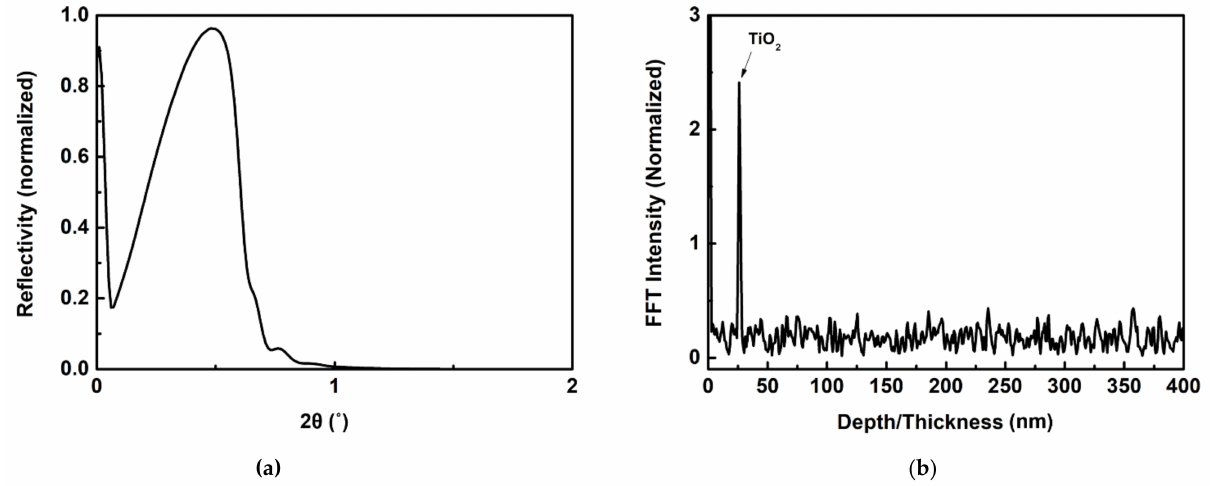
Figure 8. ( a ) X-ray reflectivity curve of TiO 2 on n-Si (100). ( b ) The Fourier transform profile of the reflectivity